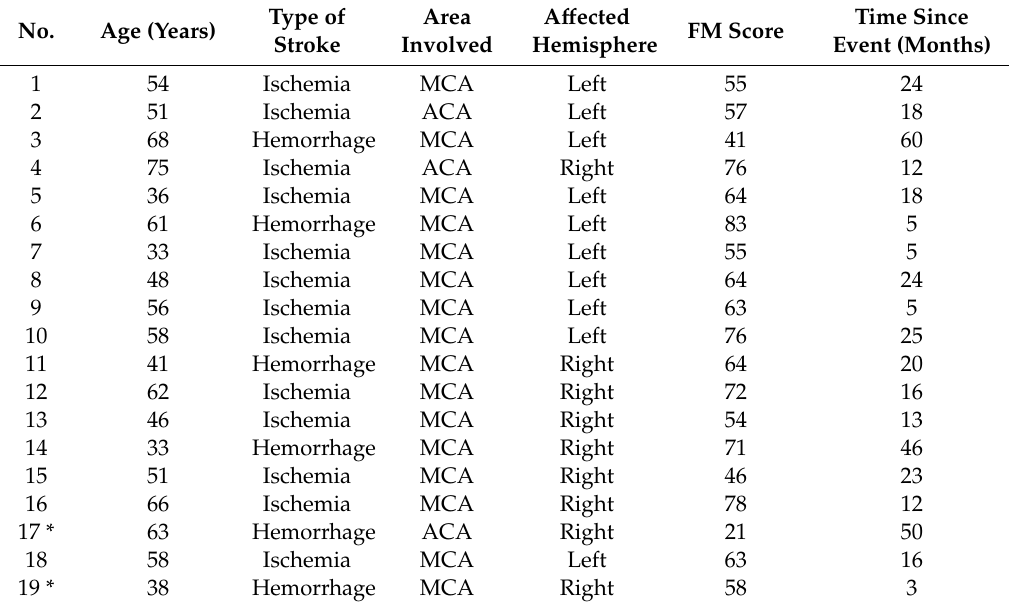
Table 1. Patients’